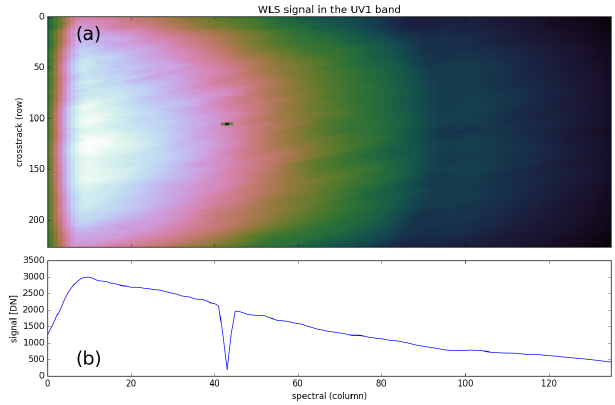
Figure 3. WLS signal in the UV1 band, corrected for background. Panel (a) shows the signal in the whole UV1 region, with a distinct dark spot around column 40 and row 100. Panel (b) shows the cross section of the signal through the